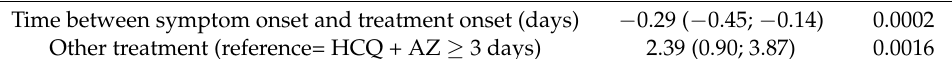
Table 3. Risk factors associated with duration of viral shedding as assessed by multivariable linear regression. Beta 95% p -Value All ( n = 2378 *) Confidence Interval Time between symptom onset and treatment onset (days) − 0.16 ( − 0.20; − 0.13) <0.0001 NEWS-2 ≥ 5 0.78 (0.16;1.41) 0.0139 Symptoms of COVID-19 at day 0 (reference = none) 1.37 (0.83;1.91) <0.001 Chronic heart disease (reference = none) 1.01 (0.28;1.74) 0.0065 Eosinophils < 0.04 G/L (reference >0.04 G/L) 0.83 (0.51;1.16) <0.001 Beta 95% p -value Patients aged 65 and older ( n = 294) confidence interval Time between symptom onset and treatment onset (days) − 0.29 ( − 0.45; − 0.14) 0.0002 Other treatment (reference= HCQ + AZ ≥ 3 days) 2.39 (0.90; 3.87)